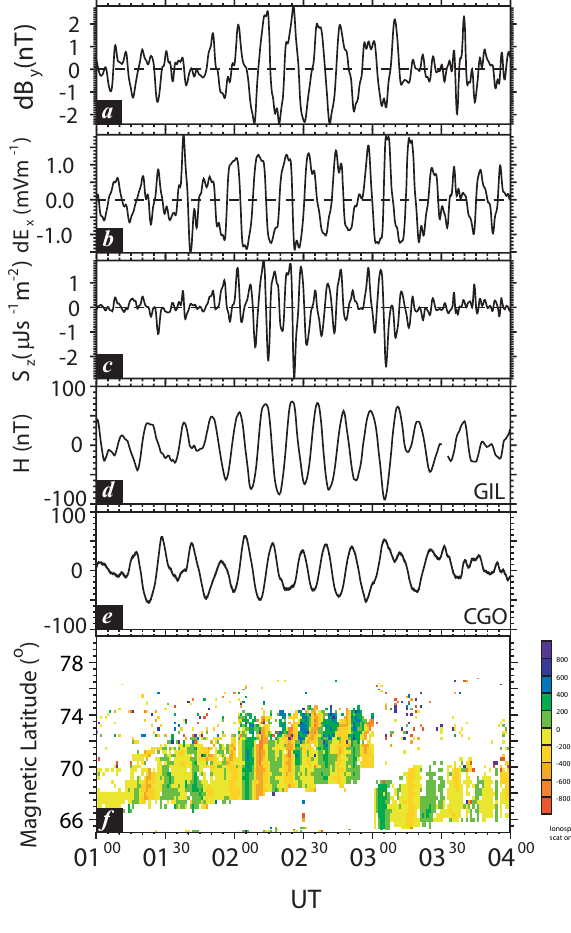
Fig. 3. (a) , (b) the in-situ ∼ azimuthal and ∼ radial magnetic and electric fields, respectively, as measured by the Polar space- craft, and using the field-aligned co-ordinate system outlined in R05. (c) shows the in-situ field-aligned Poynting vector, (d) the H-component ground magnetometer data from GIL, (e) the H- component ground magnetometer from CGO, and (f) the l-o-s ve- locity from beam 5 of the Prince George HF radar. These datasets have been plotted between 01:00–04:00 UT on the 25 November